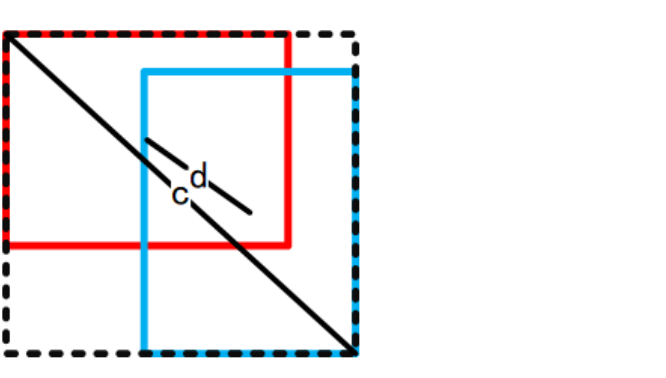
Figure 4. Figure of complete IoU. Red: ground-truth box, Blue: predicted box, d : the Euclidean distance, c : the minimum bounding rectangle diagonal length of predicted boxes and ground-truth boxes.